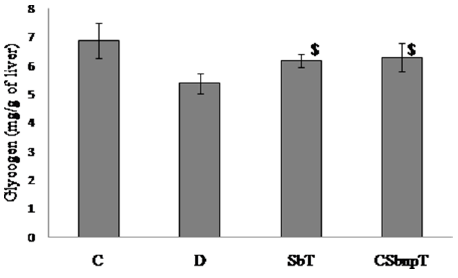
Figure 8. Effect of Sb and CSbnp on liver glycogen content. C- control group, D – diabetic group, SbT – Sb treated group, CSbnpT – CSbnp treated group. Results were expressed as mean 6 SD (n=6). $ P , 0.05 significant difference compared with D